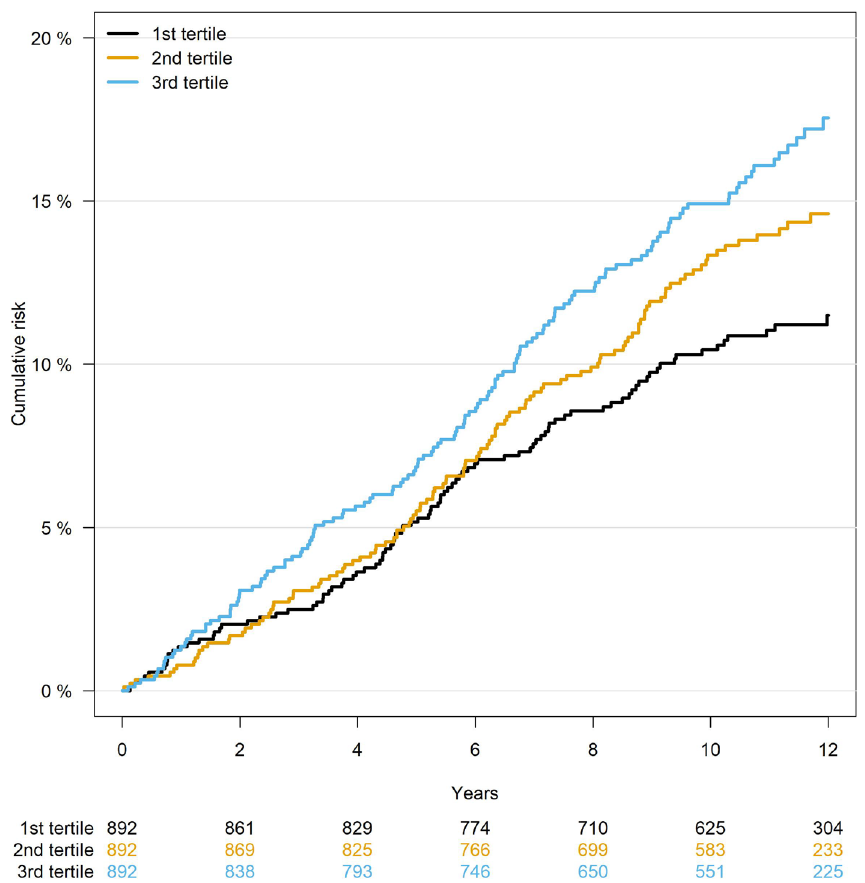
Figure 1. Cumulative risk curve of AF in tertile groups for the eicosanoid composite score. The score represented a weighted combination of six eicosanoids associated with incident AF. Participants were divided into three tertile groups based on their scores. Lower panel shows the number of participants at risk during the study